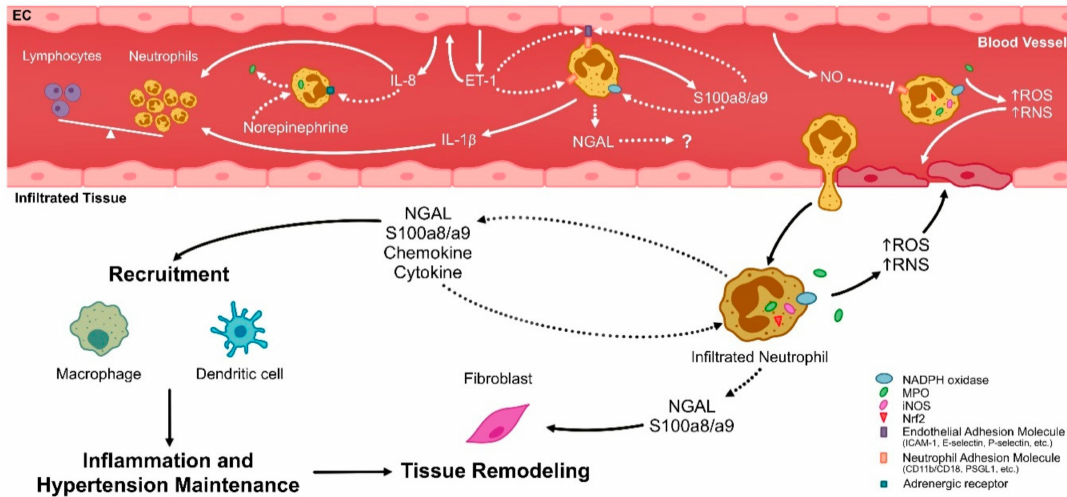
Figure 1. Possible mechanisms of neutrophils in the pathophysiology of AH. In arterial hypertension (AH) there is an increase in circulating neutrophils, represented as total neutrophil count or neutrophil / lymphocyte ratio (NLR), which can be influenced by interleukin (IL)-1 β secreted by activated neutrophils and IL-8, which in turn is secreted from endothelial cells (ECs) and induced by endothelin-1 (ET-1). In addition, IL-8 can induce adrenergic receptors in neutrophils, promoting their activation. ET-1 would increase the expression of adhesion molecules favoring the EC–neutrophil interaction and adhesion process. In the same way, S100a8 / a9 secreted by neutrophils may induce adhesion molecules in ECs. Adhesion and rolling process are promoted by reactive oxygen species (ROS) and inhibited by nitric oxide (NO) derived from ECs. Circulating neutrophils, as well as neutrophils that infiltrate tissue, generate ROS and reactive nitrogen species (RNS) through enzymes such as Nicotinamide adenine dinucleotide phosphate (NADPH) oxidase, myeloperoxidase (MPO) which can be released by adrenergic stimulation, and inducible nitric oxide synthase (iNOS) during the AH. In addition, NF-E2-related factor-2 (Nrf-2) is retained in the cytosolic compartment of neutrophils, avoiding the induction of antioxidant enzymes. Together, this oxidative and nitrative stress may cause endothelial damage, inducing vascular dysfunction and AH. On the other hand, neutrophils promote tissue damage and immune cell recruitment, such as macrophages and dendritic cells, through the secretion of cytokines, chemokines, neutrophil gelatinase-associated lipocalin (NGAL), or S100a8 / a9. In turn, these molecules may induce an autocrine e ff ect on blood neutrophils, promoting their activation, as well as on infiltrated tissues, promoting remodeling processes perpetuating the AH. Continuous and intermittent lines represent demonstrated and hypothesized mechanisms in AH,